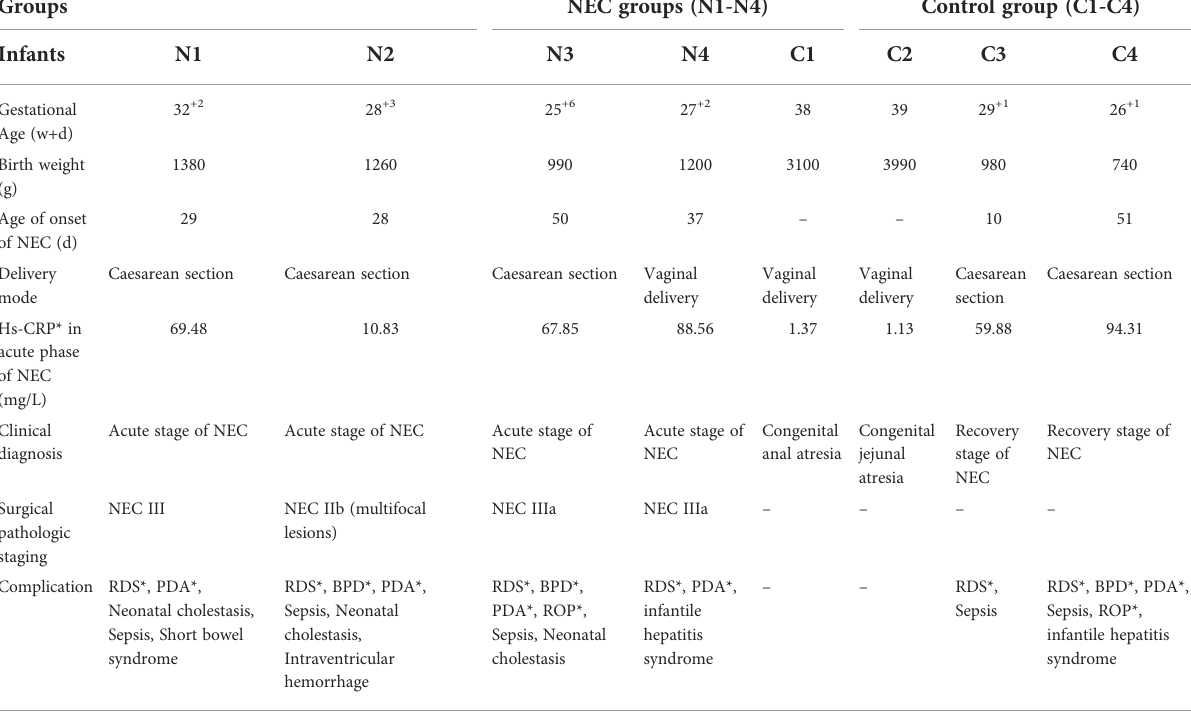
TABLE 1 Clinical and laboratory data of NEC infants and control volunteers (n=8). Groups